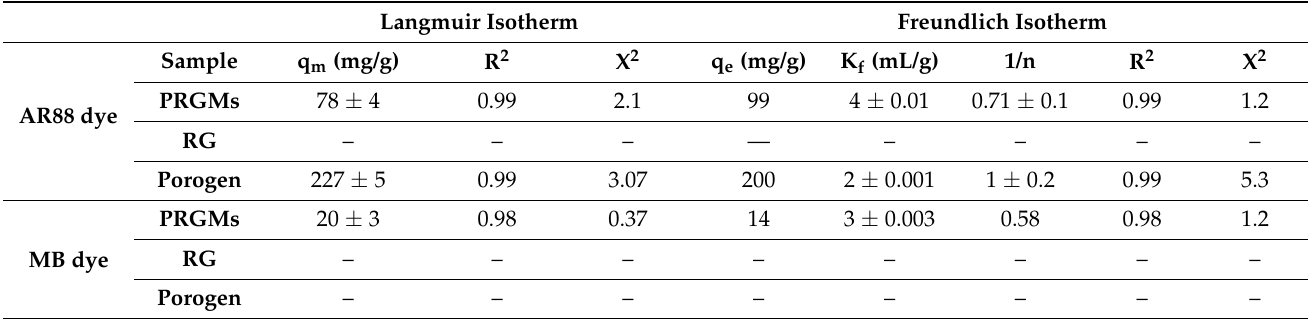
Table 2. Isotherm constants for adsorption of AR88 and MB.